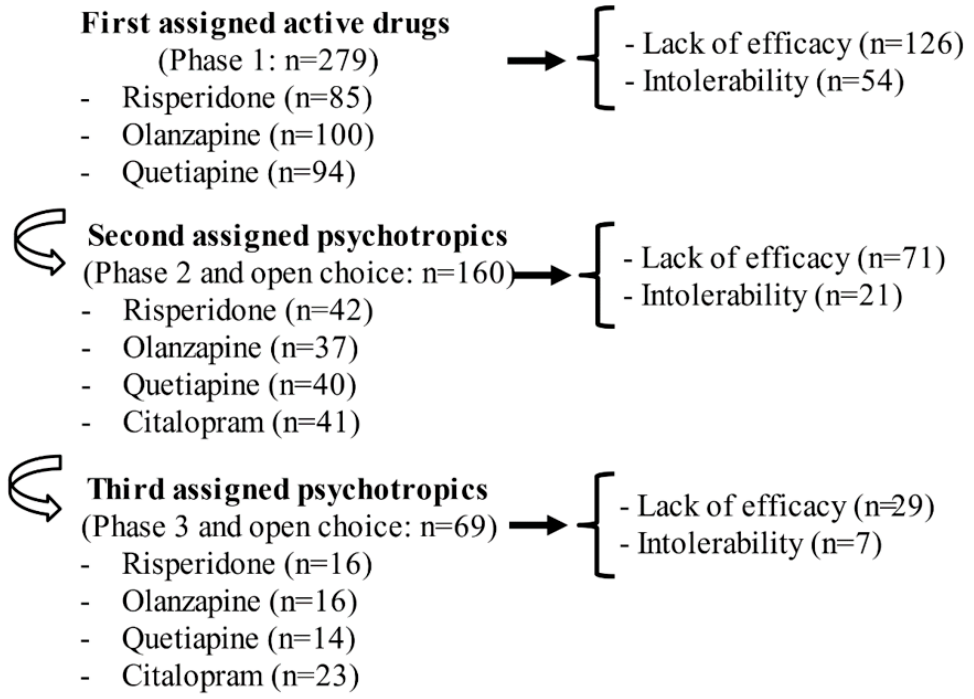
Figure 1. Switching of AAPs or citalopram in the CATIE-AD trial [15]. The results are summarized based on reference [15] and a re-analysis of the raw data. Abbreviations: AAPs: atypical antipsy- chotics, CATIE-AD: Clinical Antipsychotic Trials of Intervention Effectiveness–Alzheimer’s